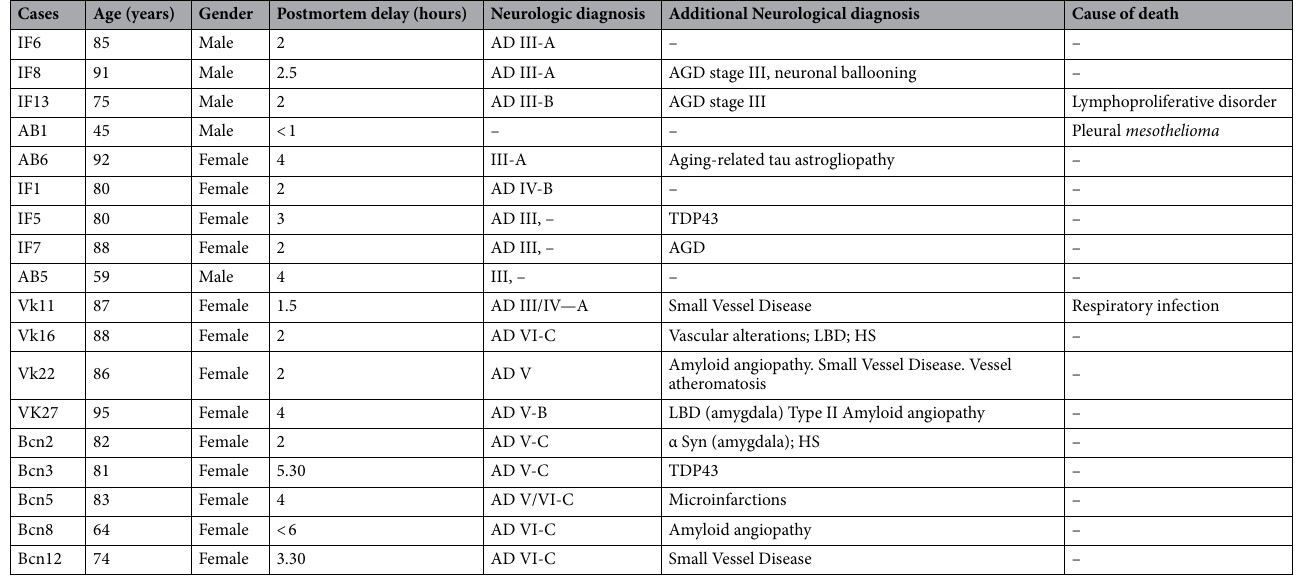
Table 1. Summary of clinical data and neurologic diagnosis according to Braak and Braak criteria 40 , defined by different stages (from I to VI), and according to CERAD criteria (Consortium to Establish a Registry for Alzheimer’s Disease) 41 , which use a semiquantitative score of the density of neuritic plaques in the most severely affected region of the isocortex (A = mild presence of plaques, B = moderate presence of plaques, C = severe presence of plaques). We have used an internal code to ensure the confidentiality of each sample. Red indicates those cases in which antibodies to βIV-Spectrin labeled the AISs. AGD, Argyrophilic grain disease; LBD, Lewy body disease; HS, hippocampal sclerosis; Syn, synuclein; TDP43, TAR DNA-binding protein 43; –, not available. Cases IF6, IF8, IF13 were AD cases, whereas AB1 and AB6 were free of any known neurological or psychiatric illness (considered as